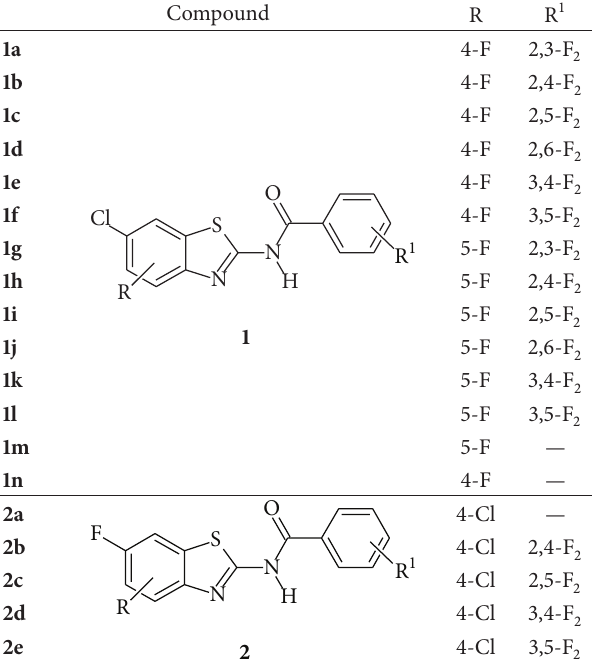
Table 1: Structures of compounds 1a–n and 2a–e